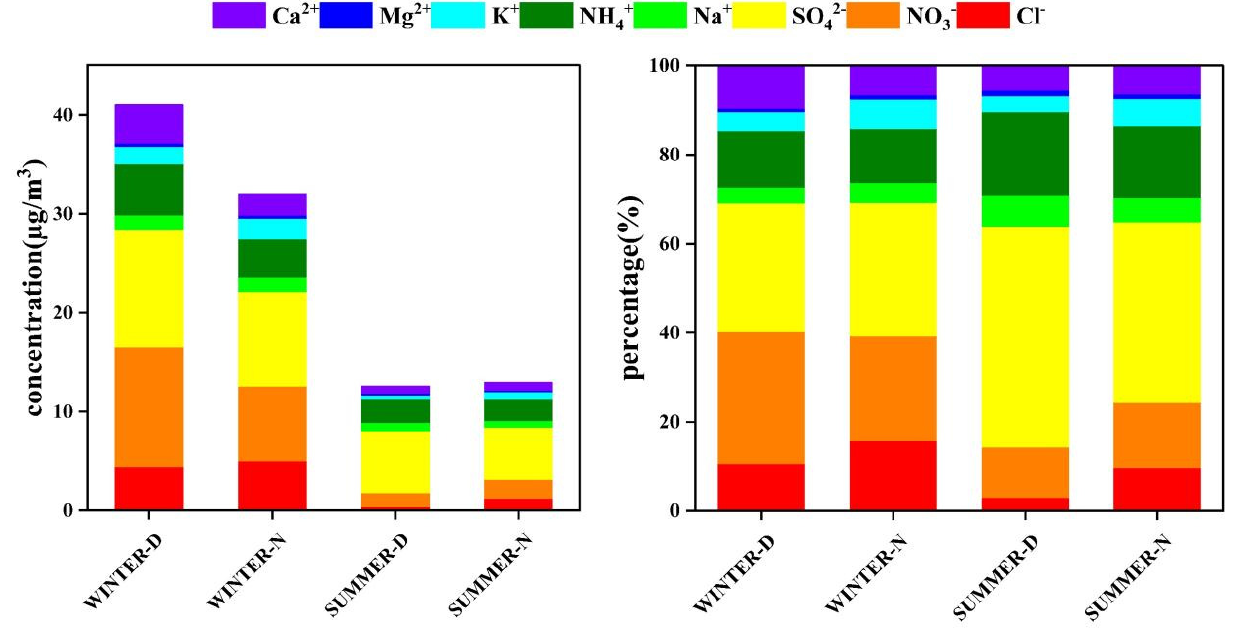
Figure 3. Average mass concentration and the proportion of water-soluble ions in Lanzhou City in winter and summer (WINTER-D: winter daytime, WINTER-N: winter nighttime, SUMMER-D: summer daytime, SUMMER-N: summer nighttime).